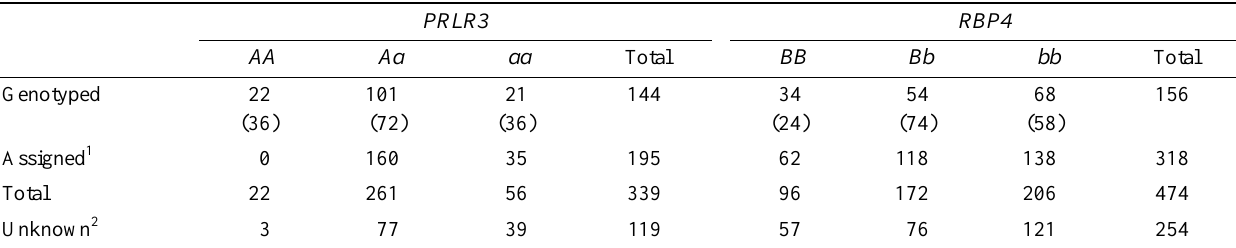
Table 1. Classification of animals by PRLR3 and RBP4